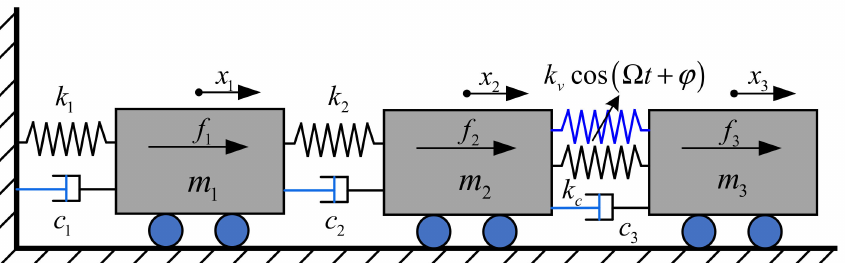
Figure 1. Three-degree-of-freedom system with stiffness cycle